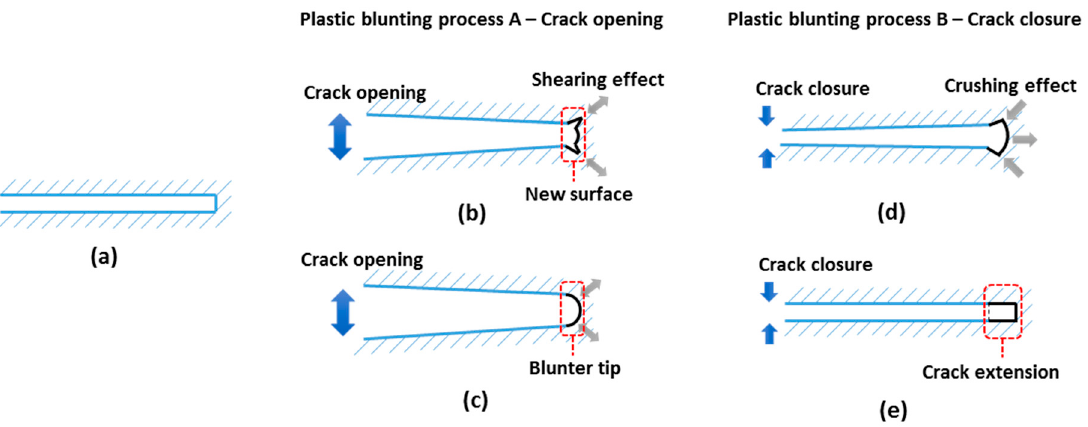
Figure 7. Plastic blunting process.